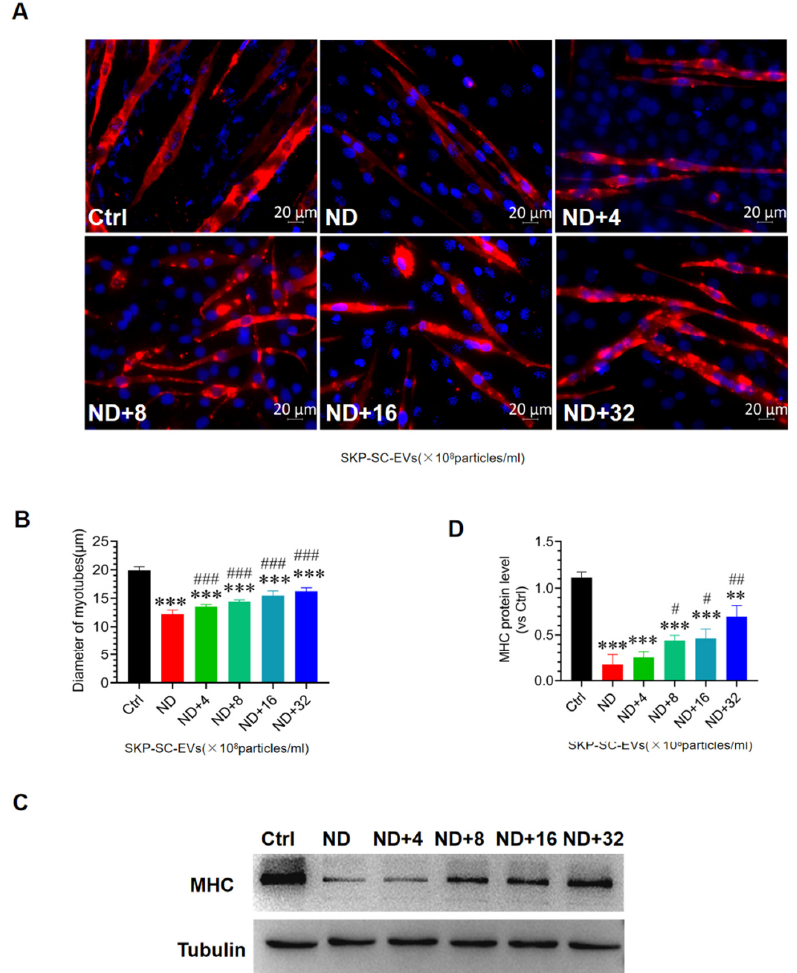
Figure 3. SKP-SC-EVs relieve C2C12 myotube atrophy caused by nutrient deprivation. ( A ) Myosin heavy chain (MHC) immunofluorescence image of myotubes 12 h after treatment with HBSS with or without SKP-SC-EVs (4 × 10 8 , 8 × 10 8 , 16 × 10 8 , and 32 × 10 8 particles/mL). Red represents MHC staining. Scale bar = 20 μ m. ( B ) Measurement of myotube diameter. After SKP-SC-EV treatment, the diameter of myotubes gradually increased. n = 4, *** p < 0.001 vs. Ctrl group, ### p < 0.001 vs. ND group. ( C ) Western blot images of MHC expression in different treatment groups. ( D ) Representative western blot detection of changes in MHC expression. n = 3, ** p < 0.01 and *** p < 0.001 vs. Ctrl group; # p < 0.05 and ## p < 0.01 vs. ND group. Ctrl, control; EVs, extracellular vesicles; HBSS, Hank’s balanced salt solution; ND, nutritional deprivation; SCs, Schwann cells; SKP, skin-derived